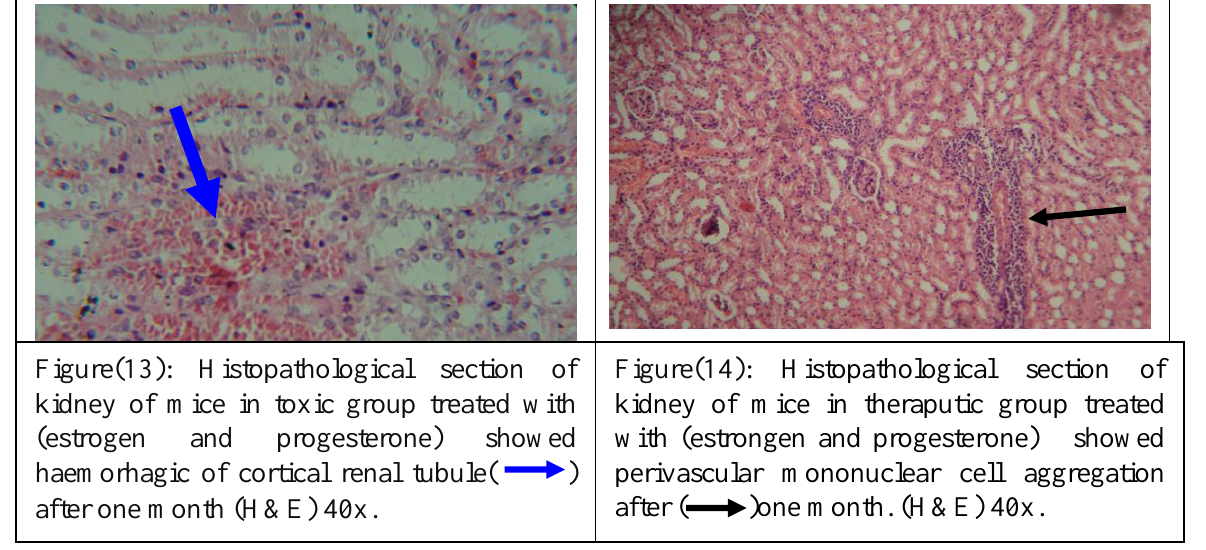
Figure(13): Histopathological section of kidney of mice in toxic group treated with (estrogen and progesterone) showed haemorhagic of cortical renal tubule( ) after one month (H&E) 40x.